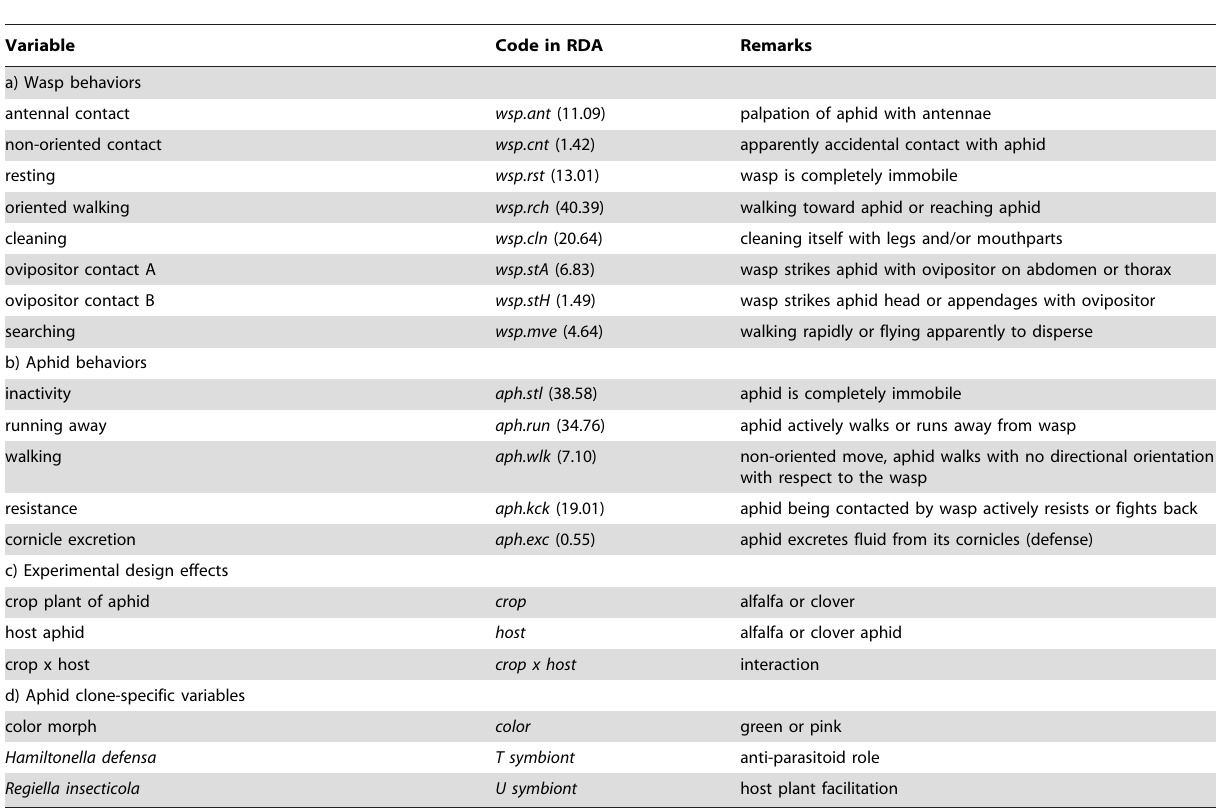
Table 2. Explanatory variables examined to predict outcomes of challenges involving 100 Aphidius ervi wasps on 600 Acyrthosiphon pisum individuals belonging to 10 field-collected clones from either alfalfa or red